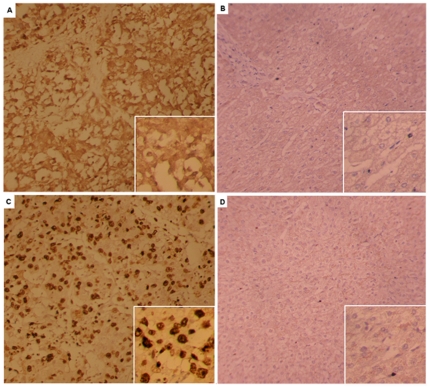
Immunohistochemical staining for MAPK1 and NCOA2 (Original magnification×200).A, MAPK1 expression was found in cell cytoplasm and/or nucleus at various levels in HCC tissues; B, MAPK1 staining was negative in paracarcinomatous liver tissues; C, NCOA2 expression was found in nucleus of tumor cells at various levels in HCC tissues; D, NCOA2 staining was negative in paracarcinomatous liver tissues.